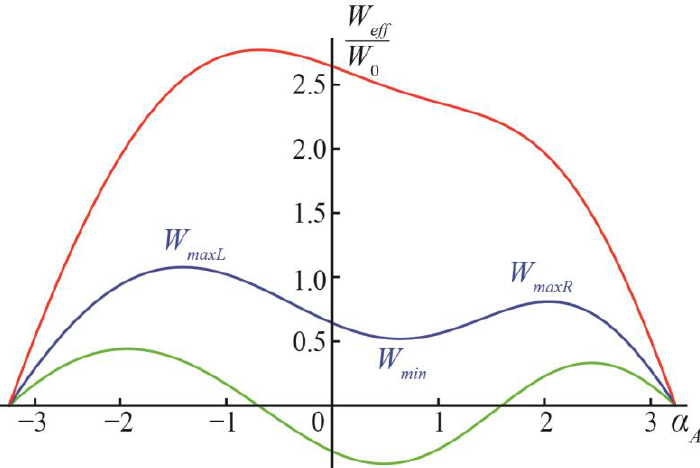
Figure 3. Dependences of W eff on α A at v = 1, y = 0.1 and: q = 0.5 (green curve); q = 1.5 (blue curve); q = 3.5 (red curve).